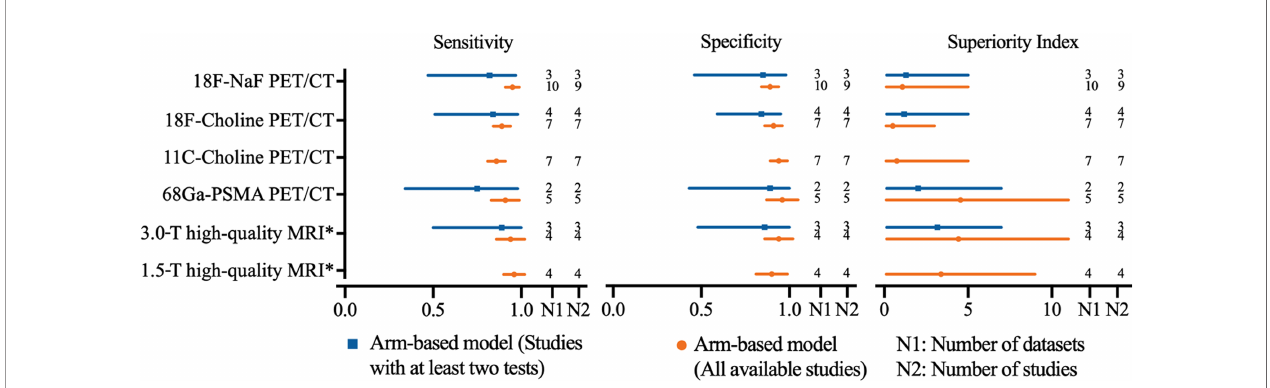
FIGURE 4 | Network meta-analysis results including sensitivity, speci fi city, and superiority index values of PET/CT with four commonly used tracers and high-quality MRI for the detection of bone metastasis in prostate cancer patients. Sensitivity, speci fi city, and superiority index are reported as mean (range) unless otherwise indicated. PET/CT, positron emission tomography/computed tomography; NaF, sodium fl uoride; PSMA, prostate membrane antigen; DWI diffusion-weighted imaging; *high-quality MRI was referred to the MRI equipped with multi-sequence, DWI used, and ≥ 2